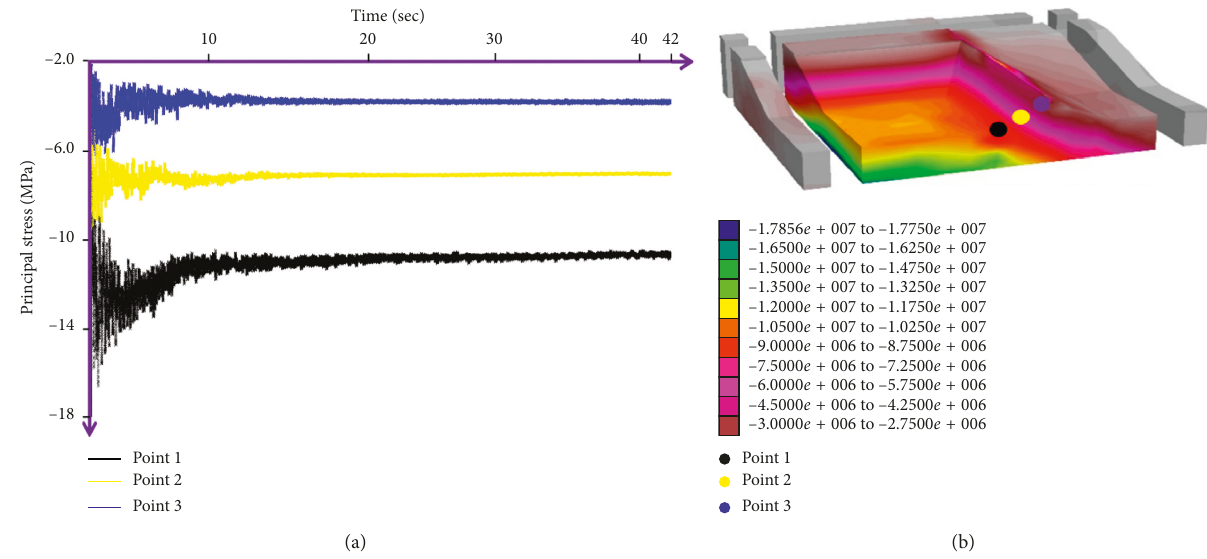
Figure 16: (a) Principal stress-time graphic for the Borrego earthquake. (b) Contour plot diagram for 42 th second of the Borrego earthquake.